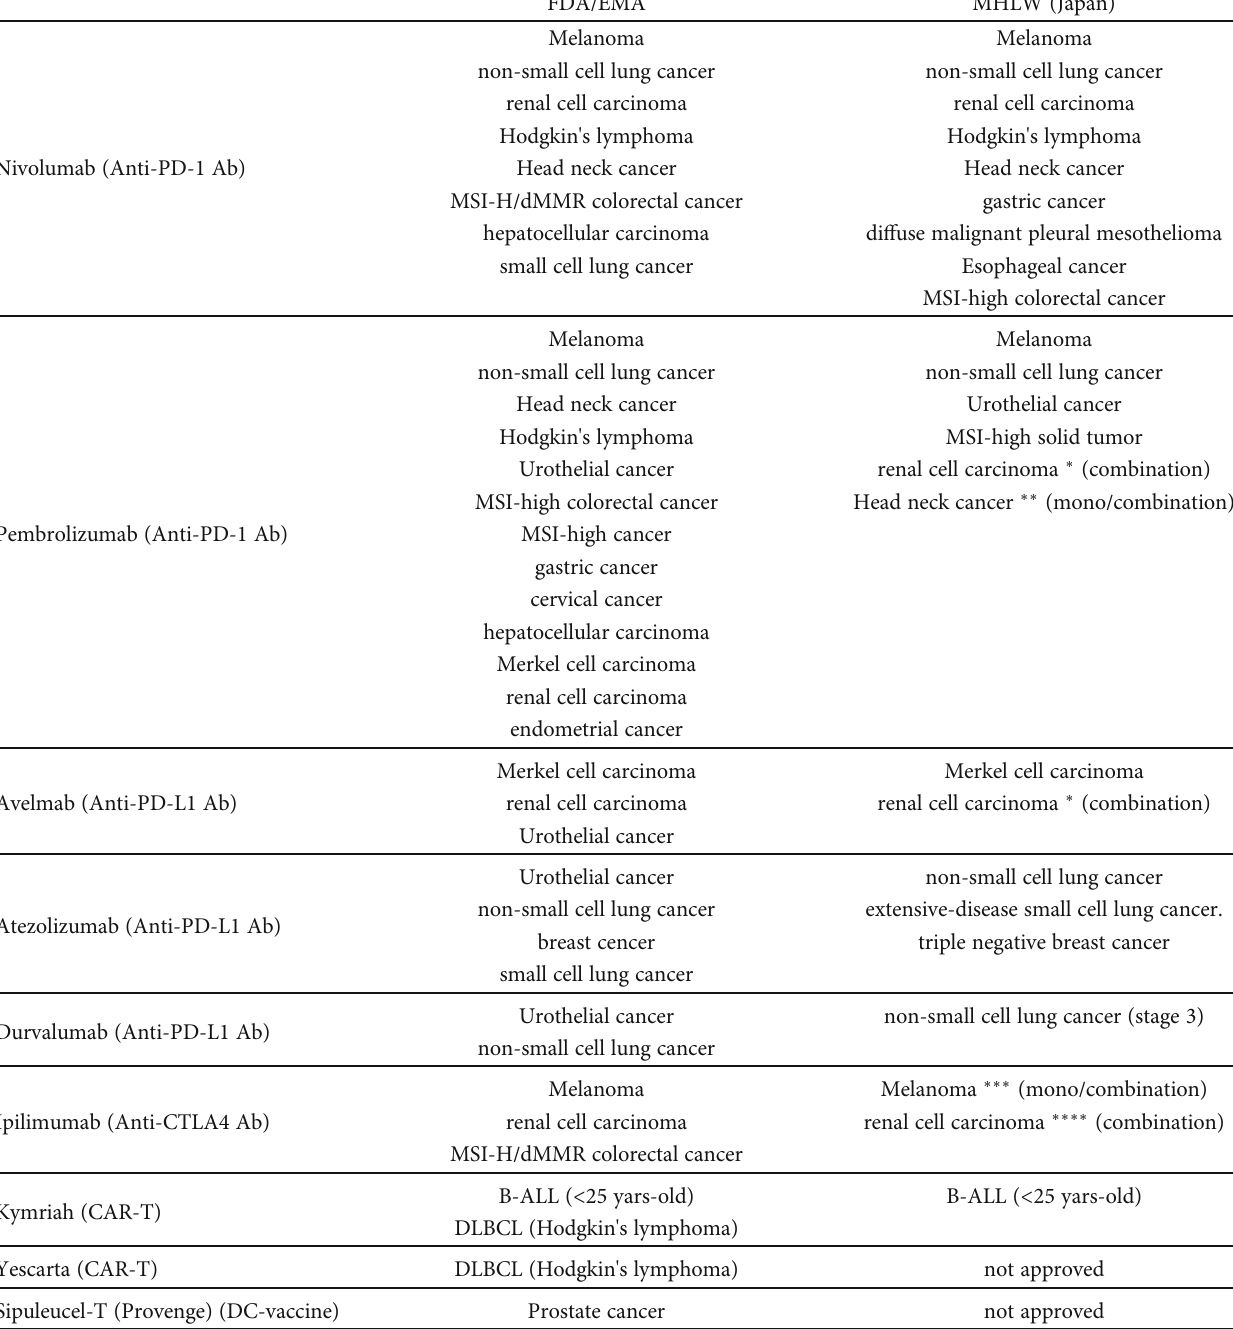
Table 1: A list of currently approved cancer